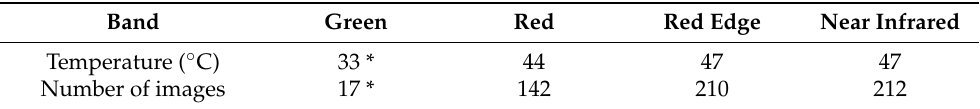
Table 4. Sequoia camera temperature when the relationship between PAR and reflectance calibra- tion panel mean values became linear (Figure 10) and the number of images captured when the temperature was reached.